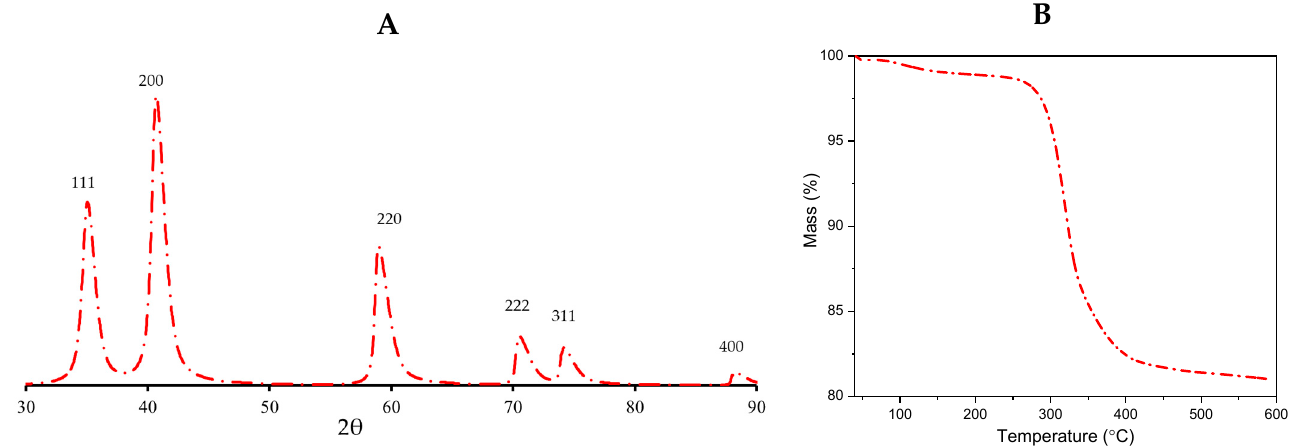
Figure 2. X-ray phase analysis ( A ) and TG curve ( B ) at 10 °C min − 1 heating rate of the synthesized nanoparticles.